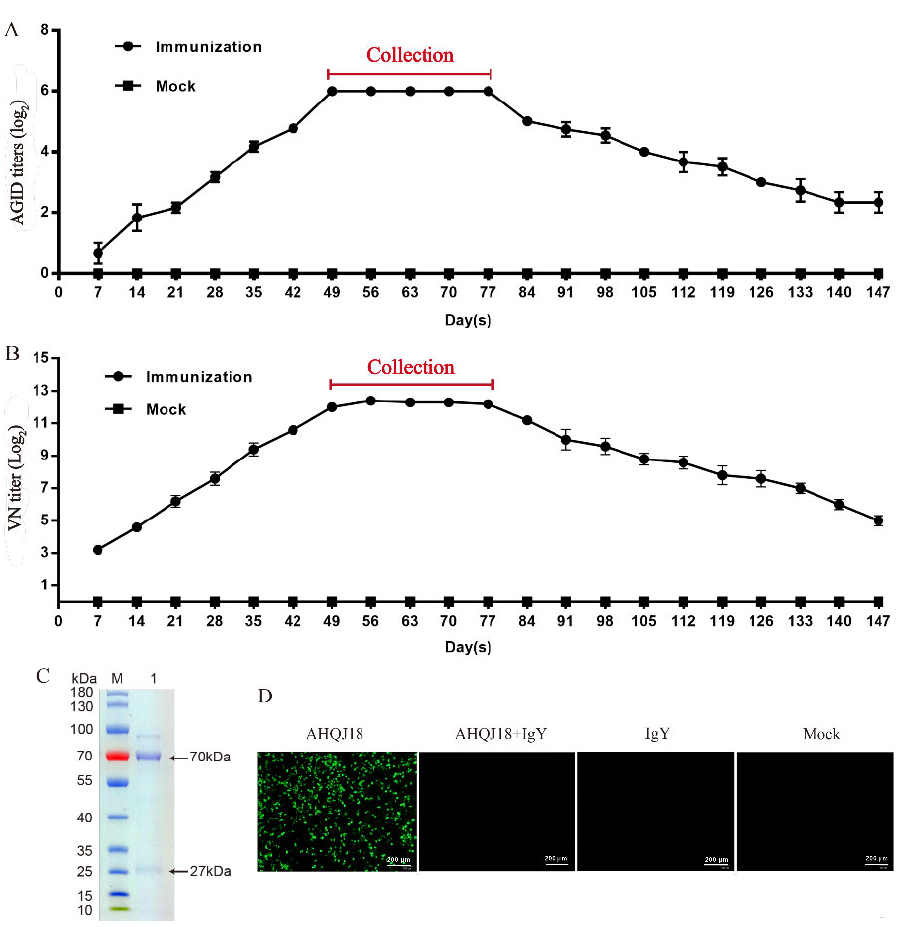
Figure 2. Preparation of anti-GAstV IgY. Antibody dynamics and collection period were determined by AGID ( A ) and VN ( B ). Red line: the collection period of the IgY. ( C ) The molecular weights and purity of the anti ‐ GAstV IgY were identified by SDS ‐ PAGE. M: Protein molecular marker. 1: IgY extracted by PEG 6000. Black arrow: the molecular weights of the heavy chains and light chains. ( D ) The fluorescence signals of the group of GAstV ‐ AHQJ18, 2 13 dilutions of IgY incubated with GAstV ‐ AHQJ18 strain, IgY, and mock were incubated in 37 °C incubator for 3 days. The fluorescence signals of GAstV ‐ AHQJ18 were detected by fluorescence microscope (×200). Scale bar = 200 μ m.